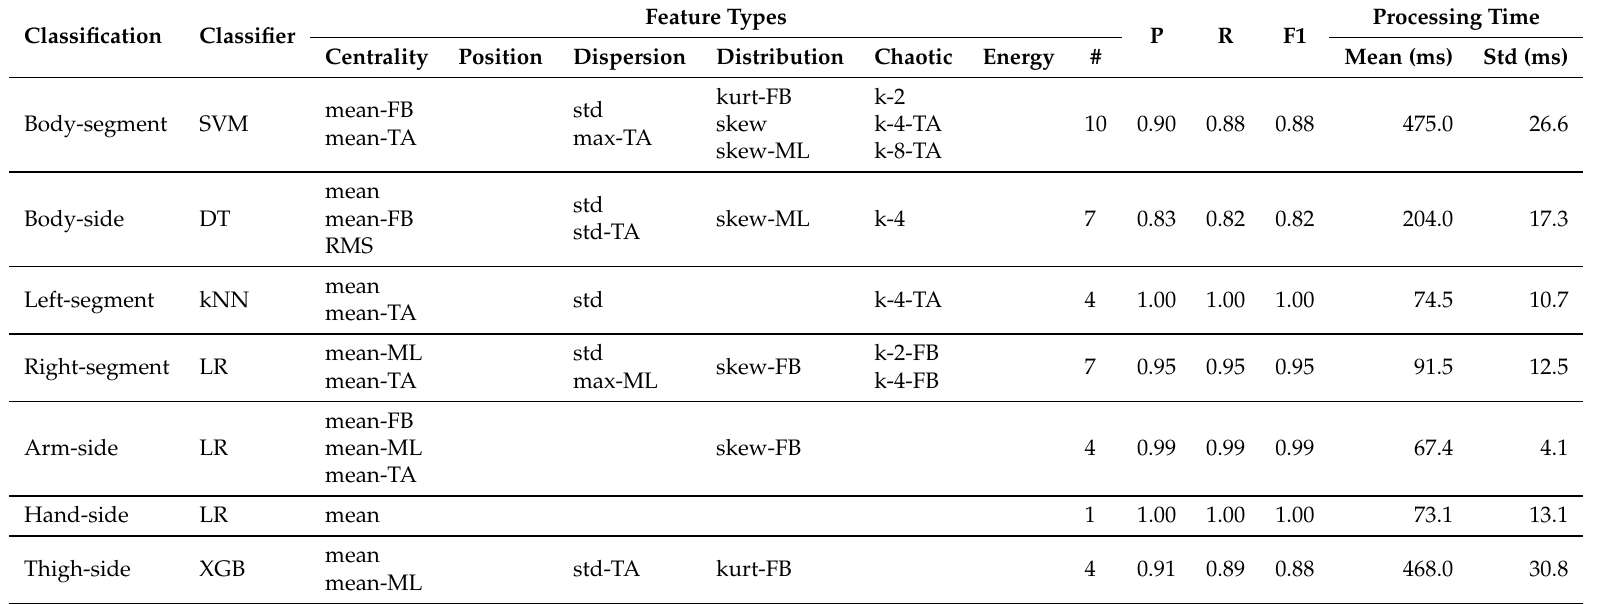
Table 7. The performance of selected features and classifiers using the